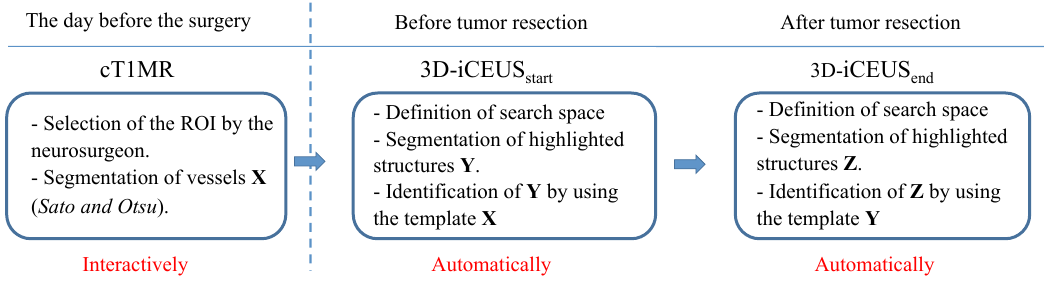
Figure 4. Workflow of the proposed